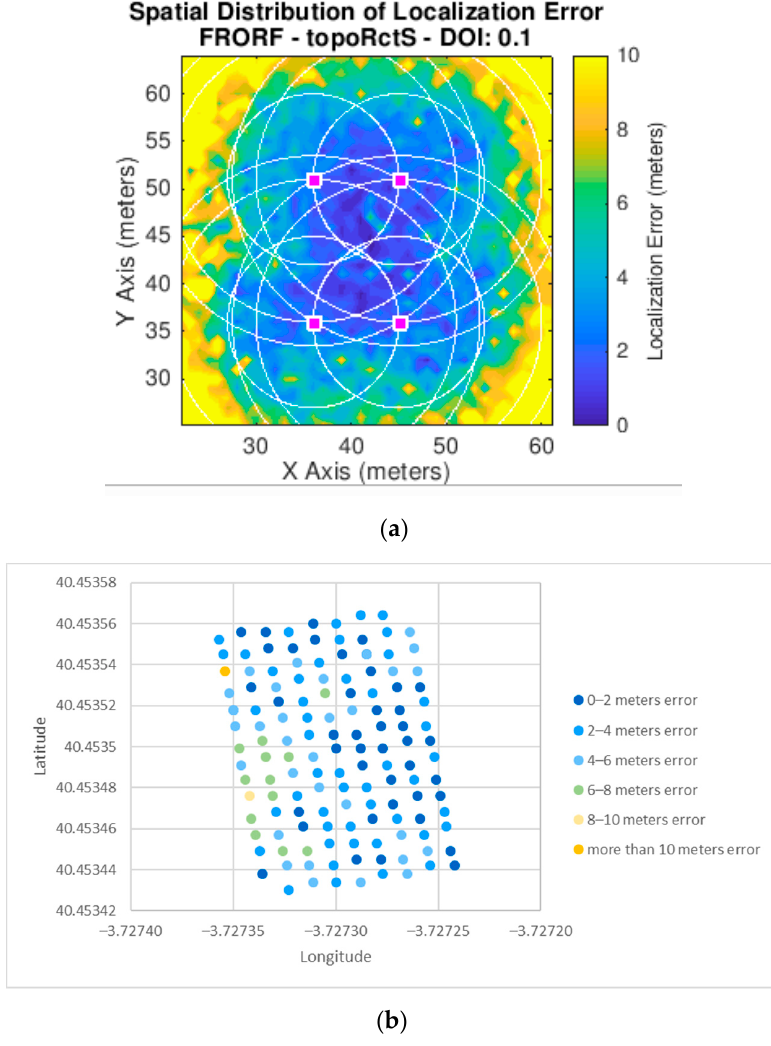
Figure 19. Experiments mean error results for scenario 1. ( a ) Scenario 1 in the simulator (p -value = 0.5); ( b ) scenario 1 in the outdoor set-up.